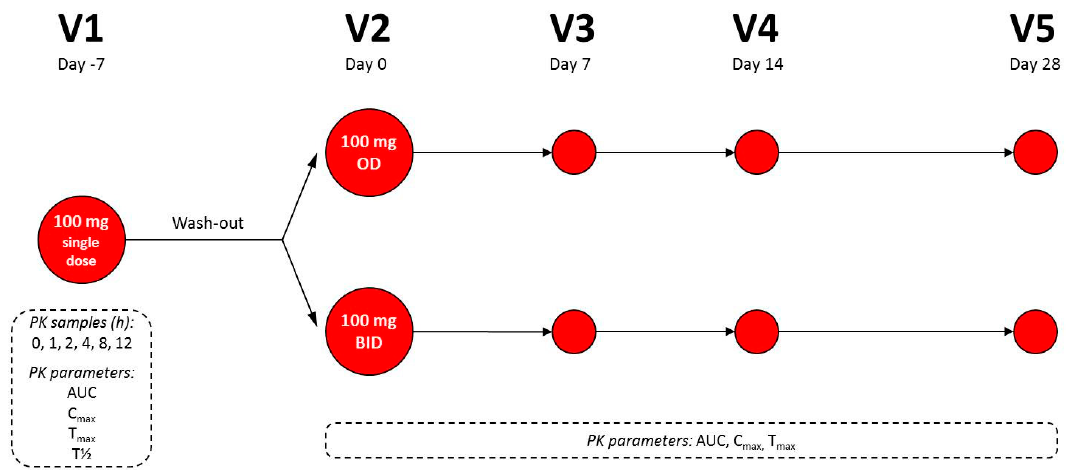
Figure 1. Flow-chart of blood sampling times (  ) for the bioavailability assessment after a single dose of 100 mg and after multiple doses of 100 mg once a day (OD) or twice a day (BID) of CoQ10. During visits, V2, V3, V4, and V5 (multiple dose phase) only had one sample (at one timepoint) was collected. AUC: area under the curve; PK: